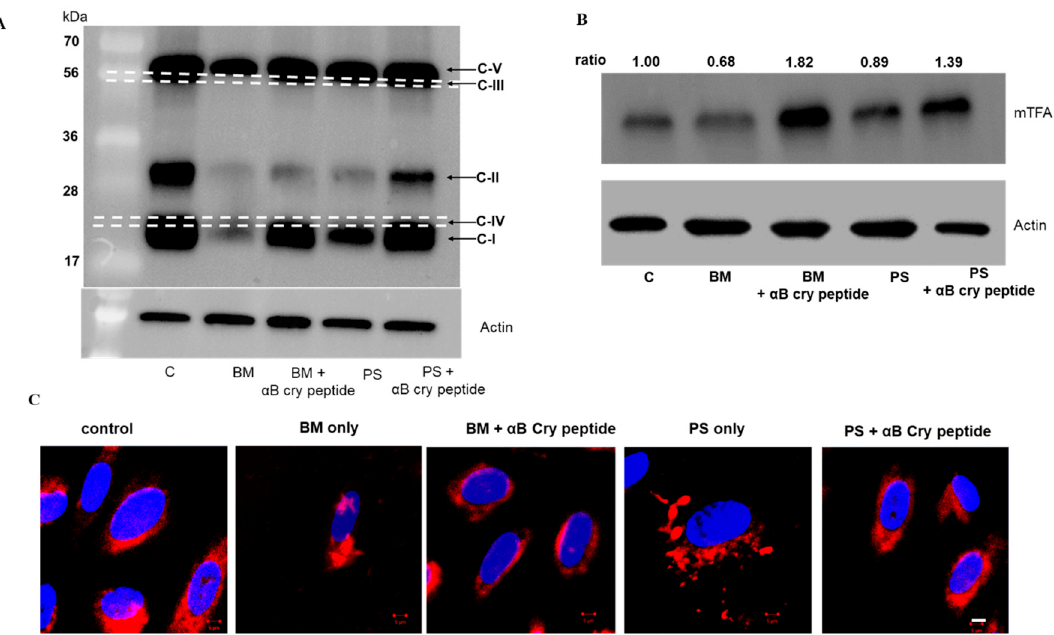
Figure 7. E ff ect of OGC and DIC inhibition on ETC proteins and mitochondrial morphology of RPE. ( A ) RPE cells were treated with and without α B cry peptide (75 µ g / mL) for 24 h and total cellular protein was analyzed by Western blot under non-reducing conditions for ETC proteins using a commercial ETC complex cocktail antibody. mGSH transport inhibition resulted in decreased expression of complex proteins I and II and α B cry peptide treatment upregulated these protein subunits. Please note that the bands for complexes I and IV appeared overlapping each other making the interpretation of changes in complex I expression di ffi cult. Complexes I and IV and complexes III and V are separated by dotted white lines in the figures for easy visualization. ( B ) Protein expression of mtTFA was measured by Western blot analysis. PS or BM treatment reduced mTFA expression, whereas co-treatment with α B cry peptide upregulated mTFA expression ( C ). RPE cells were grown on 4-well chamber slides and without α B cry peptide (75 µ g / mL) for 24 h. At the end of the treatment, cells were incubated with MitoTracker Red (100 nM) for 10 min. The samples were washed, fixed in 4% PFA and viewed under LSM 770 confocal microscope. Mitotracker (Red) and DAPI (Blue) staining of RPE cells with and without treatment. In RPE cells treated with PS (5 mM) or BM (5 mM), mitochondria appeared fragmented while in the α B cry peptide group mitochondria are perinuclear, similar to that seen in control cells. These data show that inhibition of either OGC or DIC results in an altered mitochondrial arrangement. Scale bar = 5 µ